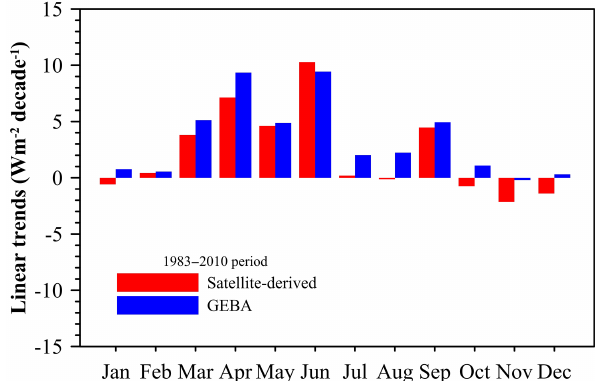
Figure 8. Linear trends in the mean monthly time series of down- ward shortwave radiation obtained as a composite from 47 GEBA station records and collocated satellite-derived records from CM- SAF over Europe over the period 1983–2010. Units in watts per square meter per decade (adapted from Sanchez-Lorenzo et al.,